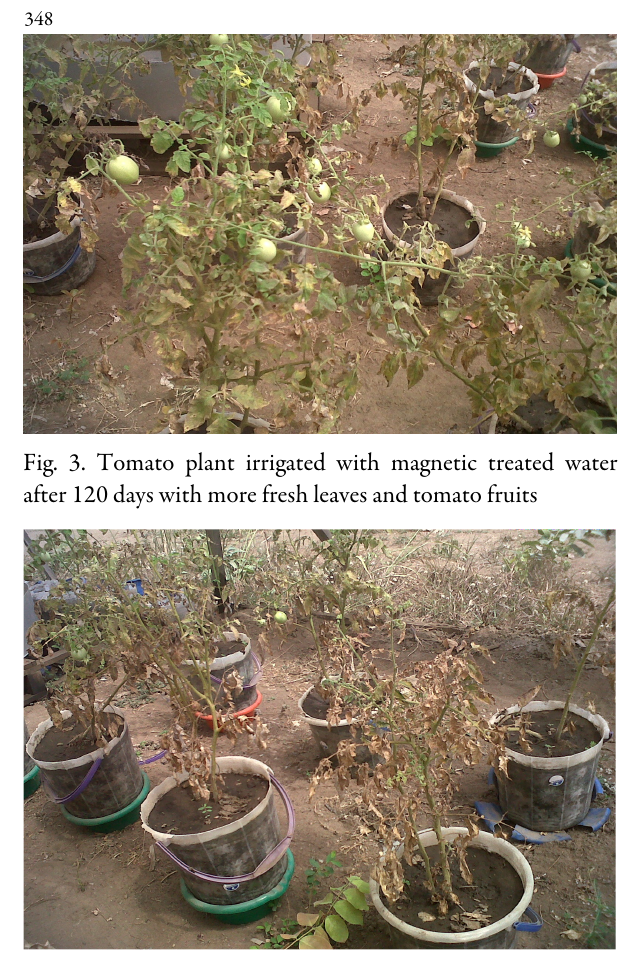
Fig. 4. Tomato plant irrigated with non – magnetic treated water after 120 days with few fresh leaves and fruits but more dry